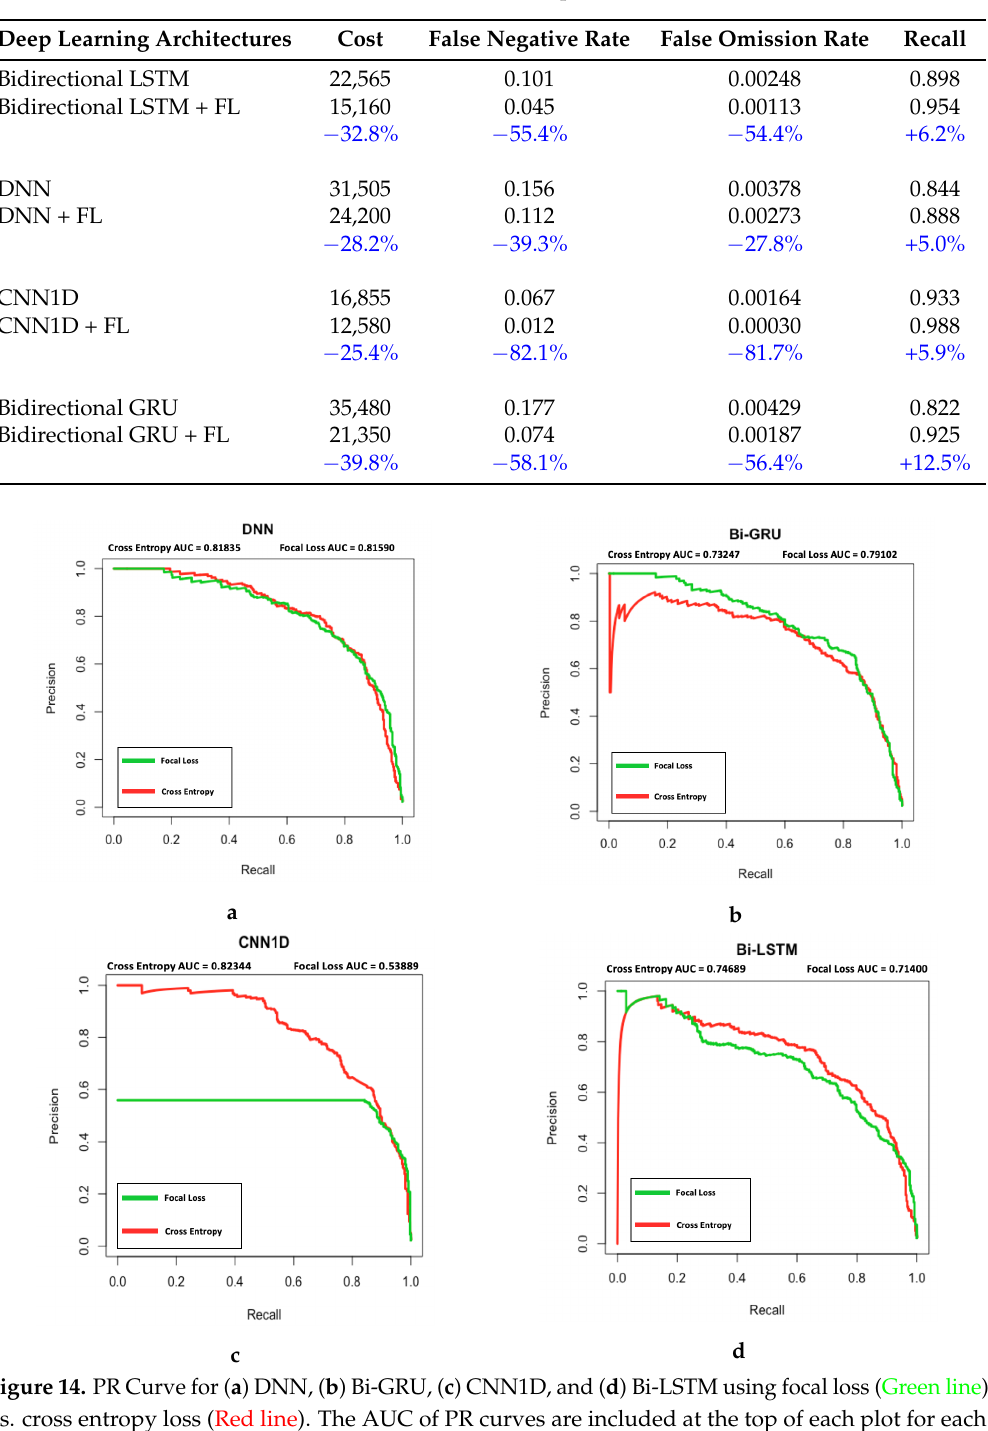
Table 6. Results of cost, false negative rate, false omission rate, and recall using Bi-LSTM, DNN, CNN1D, and Bi-GRU with and without FL. Blue colored text indicates improved performance. The values in this table are the median values across 20 experimental runs.